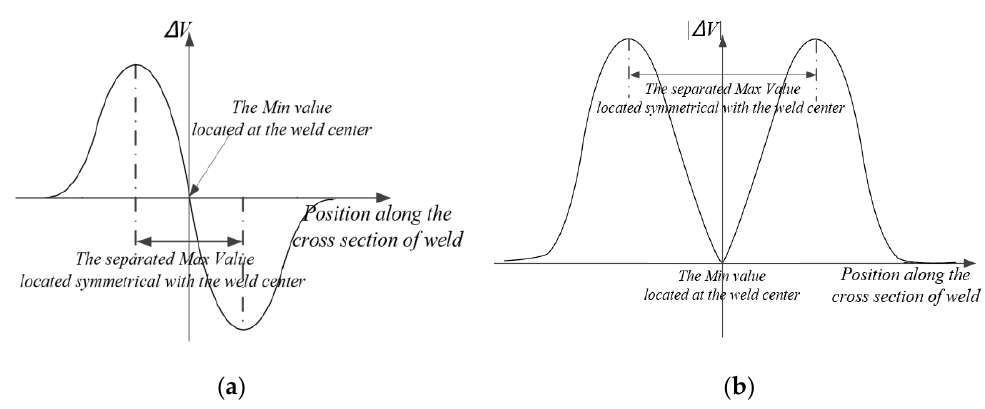
Figure 3. The sensor output signal during single scanning period ( a ) and the amplitude curve of sensor output signal ( b ).